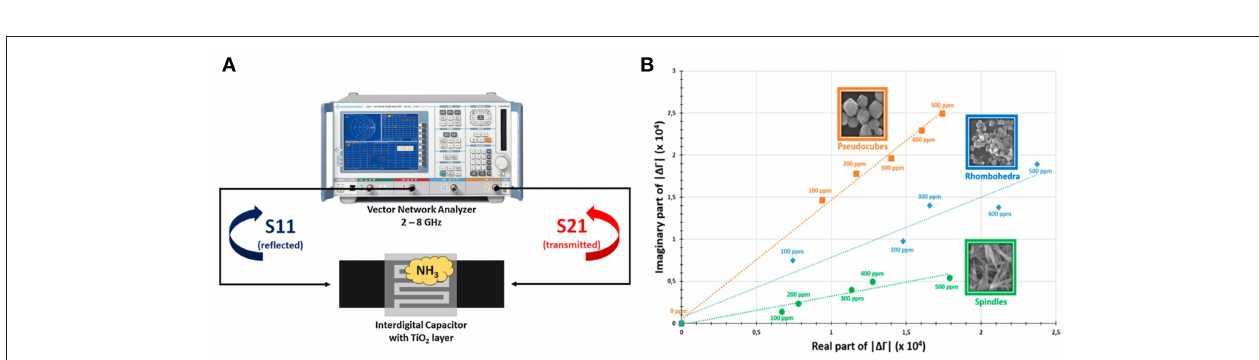
FIGURE 2 | Various propagative structures applied in microwave gas sensors. Reproduced with permissions from Fei et al. (2011), Fonseca et al. (2014), Zarifi et al. (2016) , Bogner et al. (2017), and Staszek et al. (2017). Copyright 2014, 2016, 2017 Elsevier; copyright 2016 American Chemical Society; copyright 2016 IEEE.